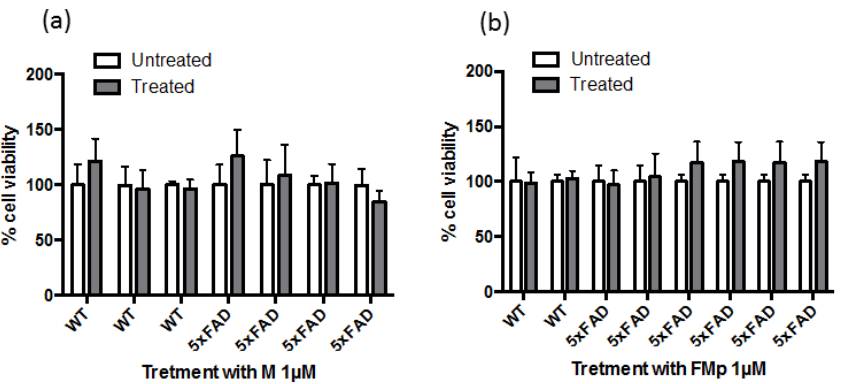
Figure 3. Cell viability of primary hippocampal cells upon treatment with ITSCs. Cells isolated from wild type (WT) and 5xFAD mice were treated for 24 h with 10 µ M of M ( a ) and FMp ( b ). Results were expressed as the mean ± s.d. for at least three independent experiments and analyzed using two-way